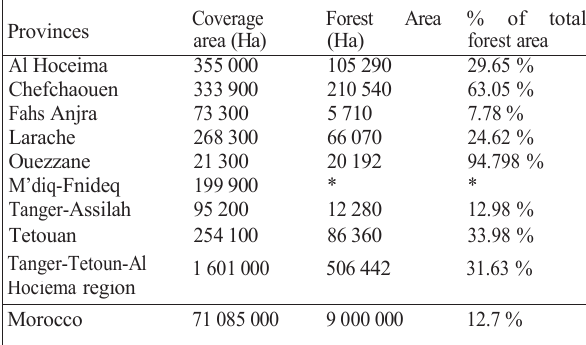
Table 1. Forest cover surfaces in northern Morocco